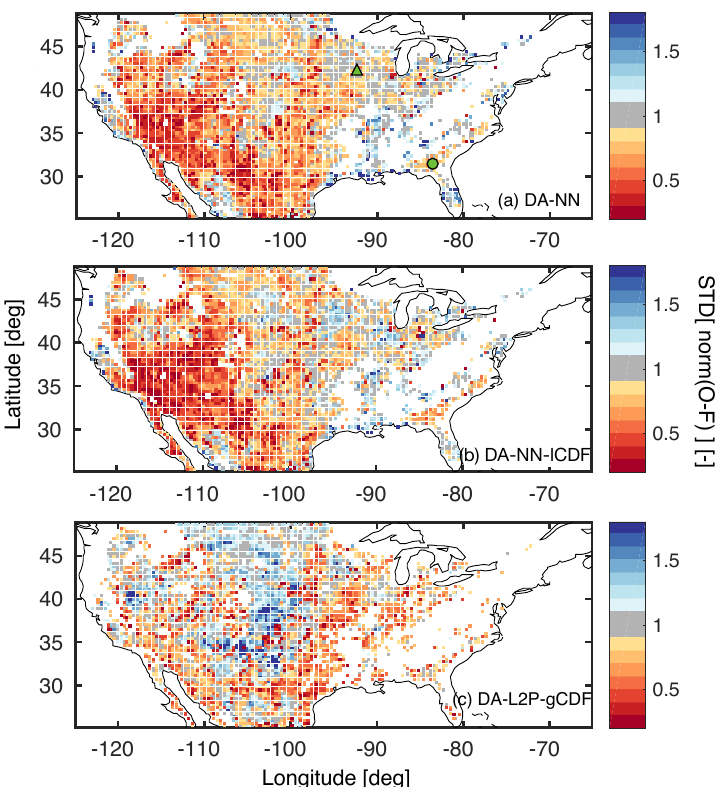
Figure 5. Standard deviation of the normalized innovations (O minus F) for ( a ) the DA-NN, ( b ) DA-NN-lCDF, and ( c ) DA-L2P-gCDF experiments. Red colors indicate that the assumed errors are overestimated with respect to the actual errors and blue colors indicate an underestimation. White areas indicate that less than 30 observations were assimilated and no metric was computed. Panel ( a ) also shows the location of the South Fork (SF; green triangle) and Little River (LR; green circle)